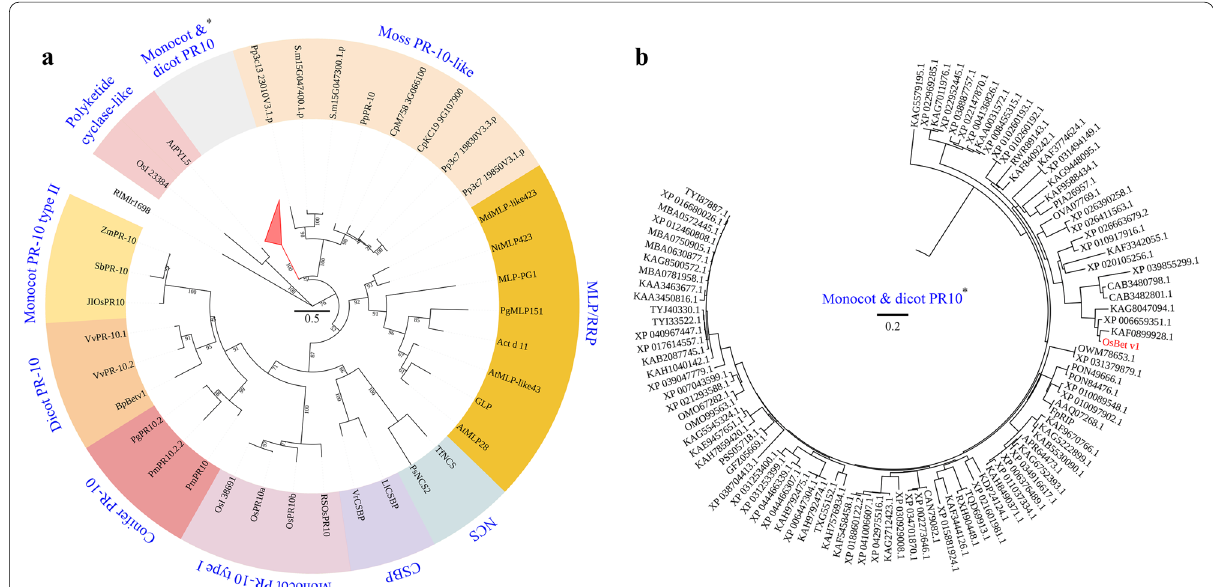
Fig. 2 The phylogenetic tree of plant PR10/Bet v1-like protein homologs. a Distance-based phylogenetic tree of members from all plant PR10/Bet v1-like protein subfamilies. The tree was rooted with Burkholderia pseudomallei . b Distance-based phylogenetic tree of members from the newly discovered subfamily ‘Monocot & dicot PR-10’ in this study. Blue letters indicate the name of each subfamily. Accession numbers of all genes are provided in Additional file 3: Table